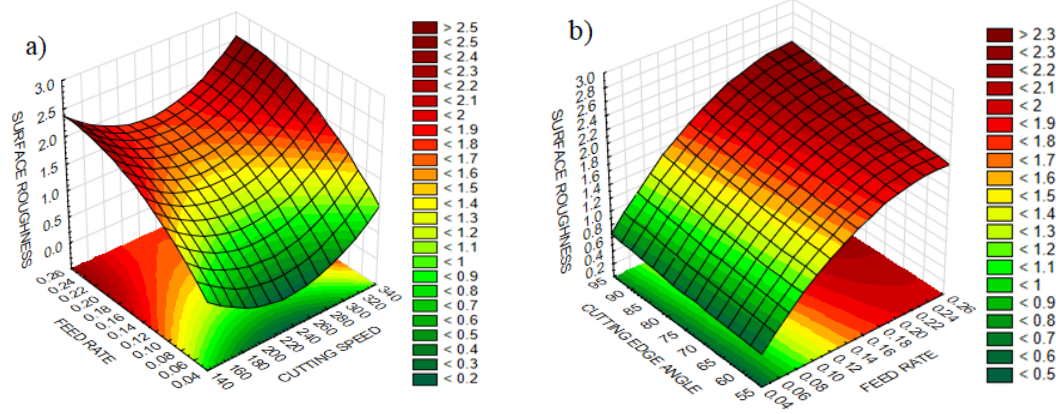
Figure 4. The e ff ect of parameters on surface roughness ( a ) Combination of feed rate and cutting speed ( b ) Combination of cutting edge angle and feed rate.